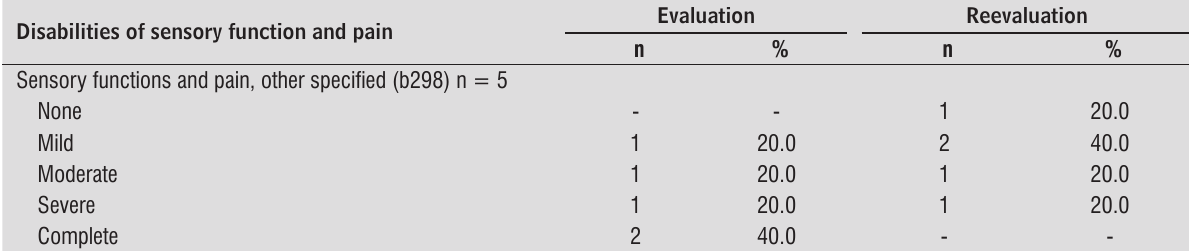
Table 3 - Distribution of the degrees of disability related to neuromusculoskeletal and movement-related function in vic- tims of traffic accidents on evaluation and reevaluation. Cuiabá/MT, 2010 Neuromusculoskeletal and movement-related disabilities Mobility of joint functions (b710) n =